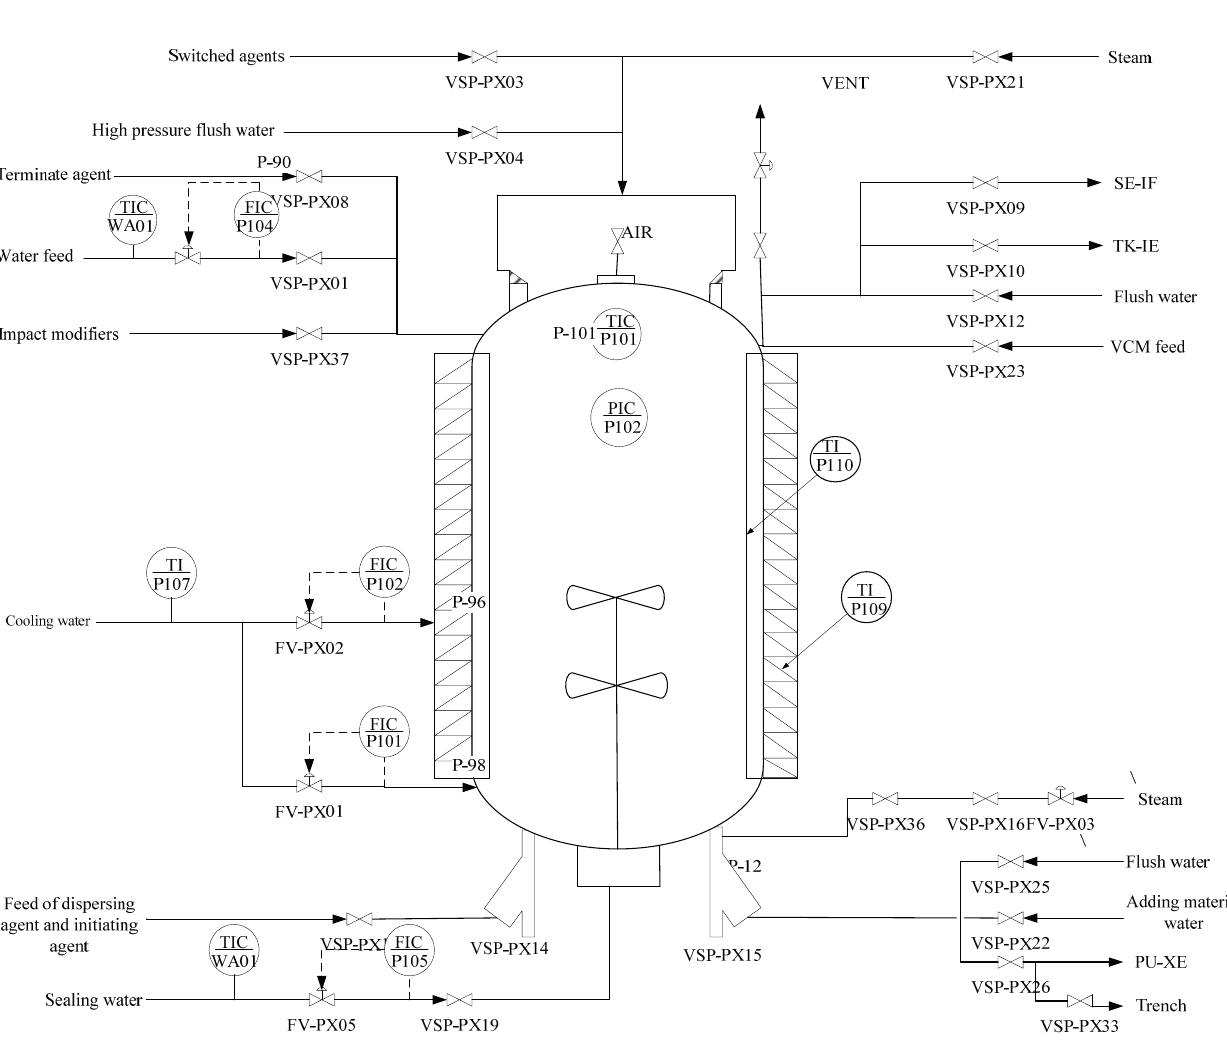
Figure 1. Flow chart of suspension polymerization.